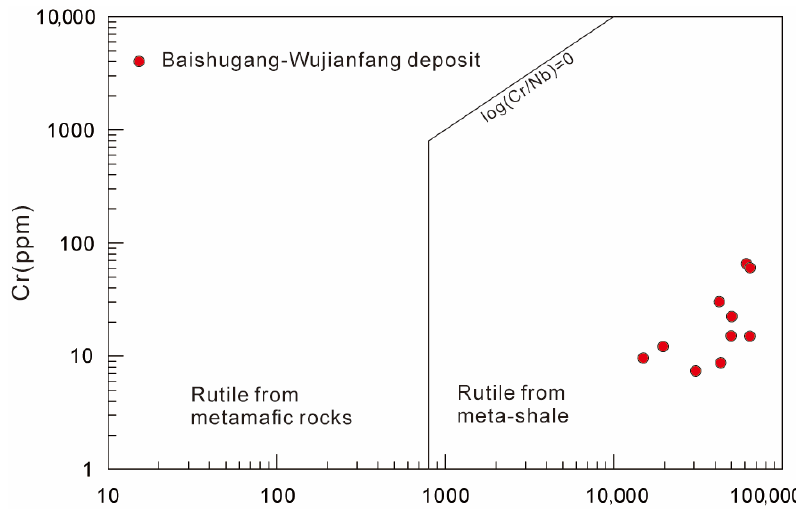
Figure 7. Cr versus Nb discrimination diagram for rutiles from the Baishugang–Wujianfang districts. Reprinted with permission from ref. [33]. 2018 Springer.